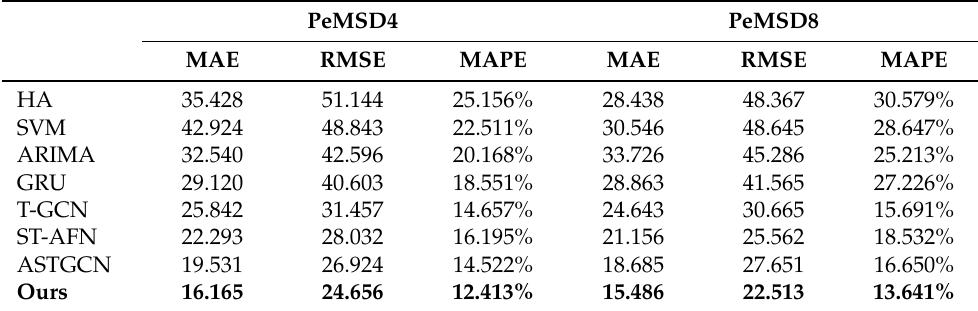
Table 2. Overall performance